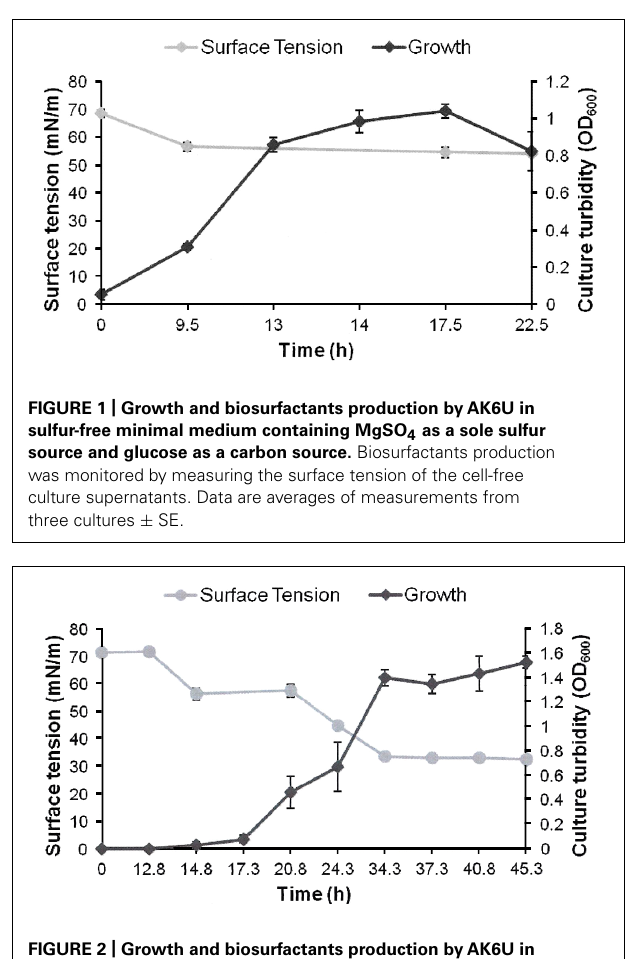
FIGURE 2 | Growth and biosurfactants production byAK6U in sulfur-free minimal medium containing DBT as a sole sulfur source and glucose as a carbon source. Biosurfactants production was monitored by measuring the surface tension of the cell-free culture supernatants. Data are averages of measurements from three cultures ± SE.